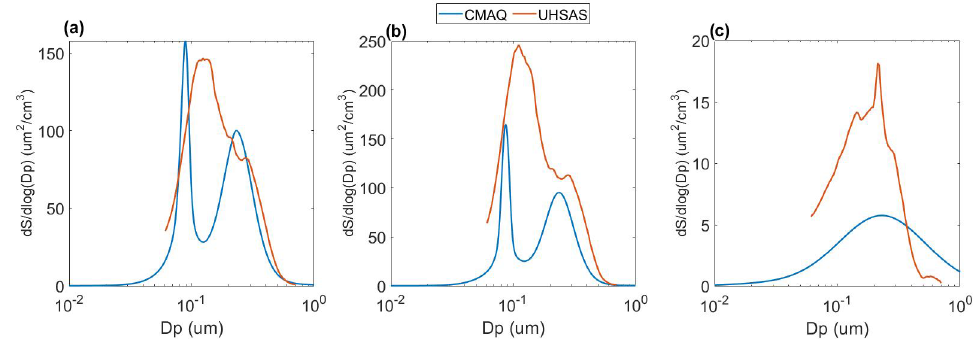
Figure 1. Modeled (blue) and measured (orange) dry aerosol surface area distributions averaged over the DISCOVER-AQ sampling domain of Baltimore and Washington, D.C. at (a) all altitudes, (b) altitudes below 1km, and (c) altitudes above 3km for 1 July